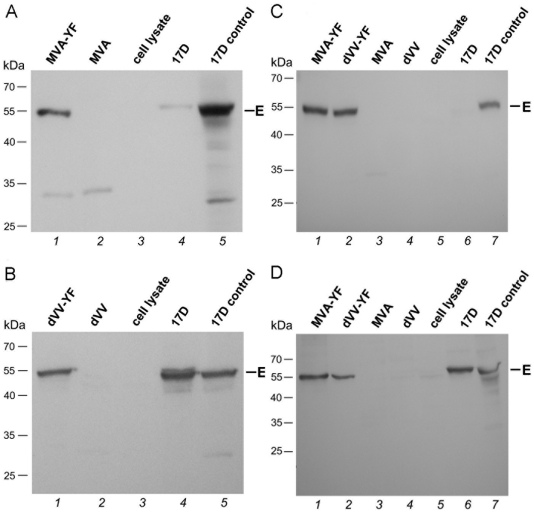
YFV prME protein expression under permissive (A and B) and non-permissive (C and D) conditions.(A) Western blot of lysates from chicken cells (DF-1) infected with MVA-YF or the corresponding controls. MVA-YF (Lane 1), wild-type MVA (Lane 2), non-infected DF-1 cells (Lane 3), positive control YFV-17D infected DF-1 cells (17D, Lane 4), YFV-17D prepared from infected HeLa cells (17D control, Lane 5). (B) Western blot of lysates from cVero22 cells infected with dVV-YF or the corresponding controls. dVV-YF (Lane 1), wild-type dVV (Lane 2), non-infected cVero22 cells (Lane 3), positive control YFV-17D infected cVero22 (17D, Lane 4), 17D control (Lane 5). Western blot of mouse muscle cells (Sol8, C) or human cells (HeLa, D) infected with the recombinants or the corresponding controls. MVA-YF (Lane 1), dVV-YF (Lane 2), wild-type MVA (Lane 3), wild-type dVV (Lane 4), non-infected Sol8 (C) HeLa (D) cells (Lane 5), cells infected with YFV-17D (17D, Lane 6), 17D control (Lane 7). The band around 55 kDa marked “E” indicates the YFV envelope protein.